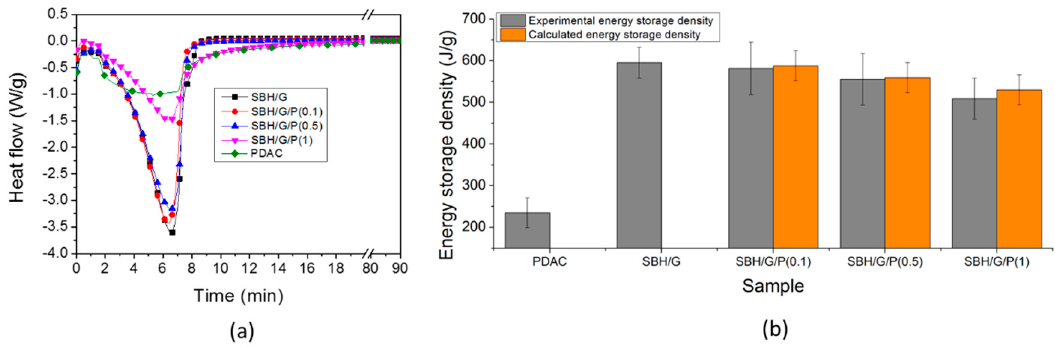
Figure 4. ( a ) Differential scanning calorimetry (DSC) curves of the prepared samples. ( b ) Experimental and calculated values for energy storage density.